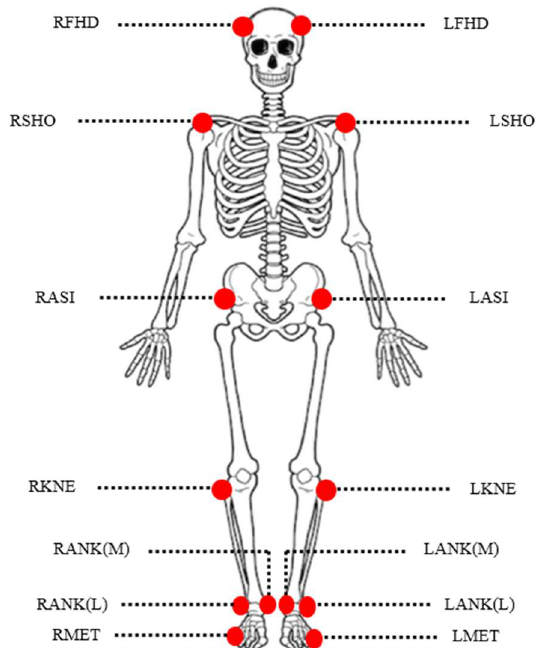
Figure 1. Reflective marker placement positions for the experiment. RFHD: located approximately over the right temple; LFHD: located approximately over the left temple; RSHO: placed on the right acromio-clavicular joint; LSHO: placed on the left acromio-clavicular joint; RASI: right anterior superior iliac spine; LASI: left anterior superior iliac spine; RKNE: placed on the lateral epicondyle of the right knee; LKNE: placed on the lateral epicondyle of the left knee; RANK(M): right medial malleolus; LANK(M): left medial malleolus; RANK(L): right lateral malleolus; LANK(L): left lateral malleolus; RMET: right 5th metatarsal head; LMET: left 5th metatarsal head.